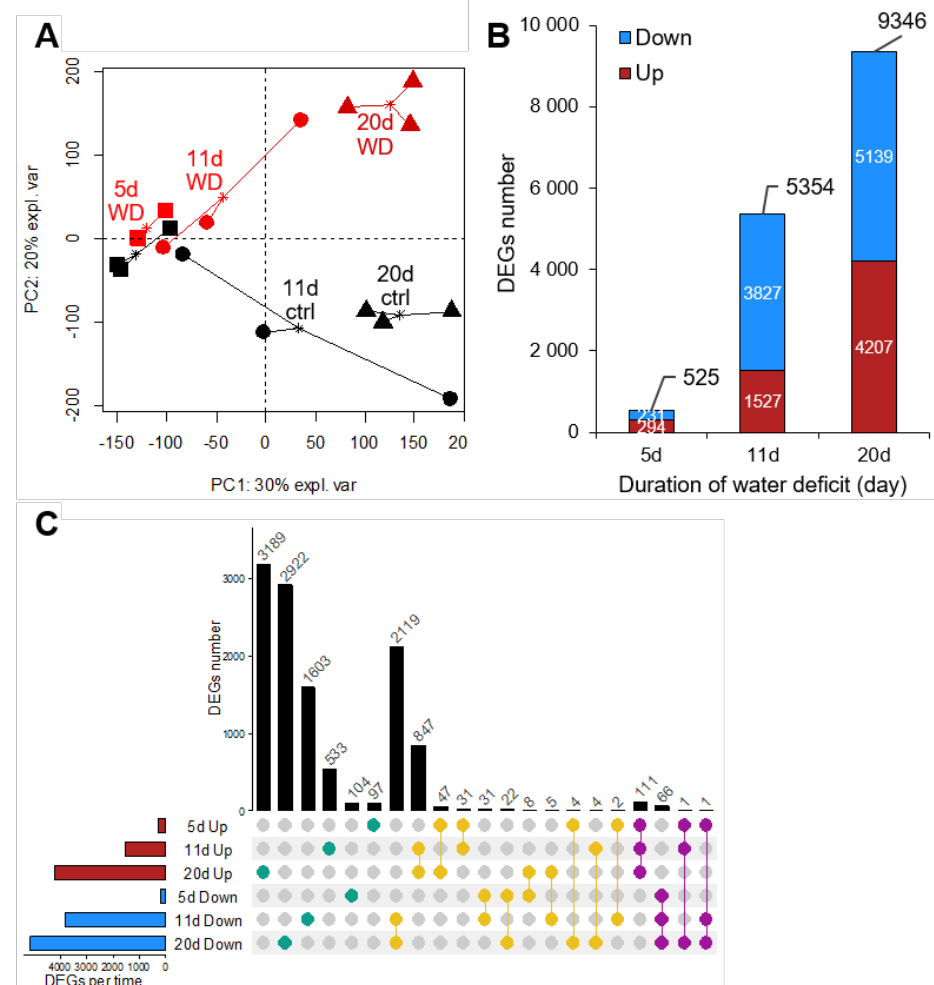
Figure 2. Exploratory data analysis of RNA-seq from B. napus leaves in response to a water deficit. ( A ) Principal Component Analysis score plot from leaf samples using normalized count data after 5 d ( ■ ), 11 d (●) , and 20 d ( ▲ ) in control ( “ ctrl ” , black) or water deficit ( “ WD ” , red) exposed plants. ( B ) Overview of the number of total and up and down DEGs identified with RNA-seq analysis in B. napus exposed to 5 d (mild), 11 d (severe), and 20 d (severe and extended) water deficit. ( C ) Distri- bution of DEGs specific to a single date of water deficit (green) or overlapped between two (yellow) or three (purple) time points. DEGs up and down-regulated are indicated in red and blue, respec- tively.